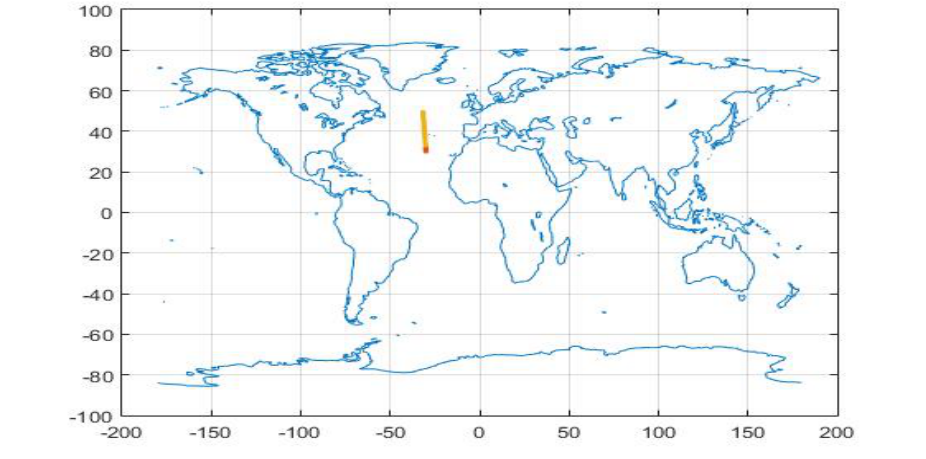
Figure 11. Launcher ground track.